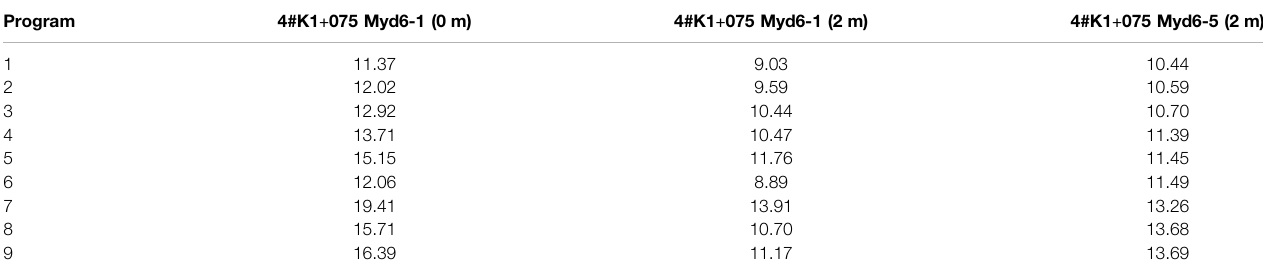
TABLE 2 | The result of orthogonal sample scheme. Program